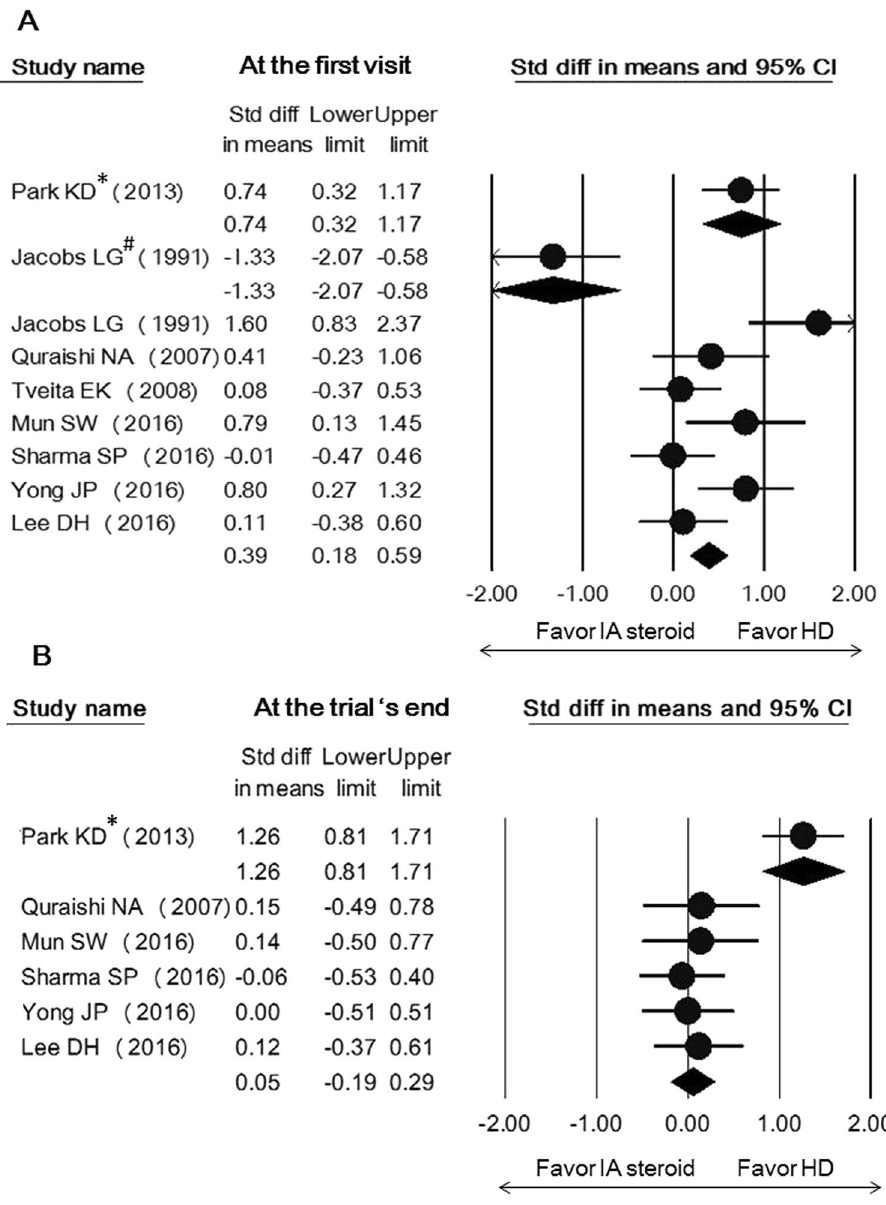
Figure 4. Forest plot of standardized mean differences of improvements in external rotation with use of hydrodilatation or an intra-articular corticosteroid injection early following intervention ( A ) and at the trial’s end ( B ). Abbreviations: hydrodilatation, HD; intra-articular, IA. * denotes the distension fluid that used hyaluronic acid instead of corticosteroid; # denotes the distension fluid that did not contain